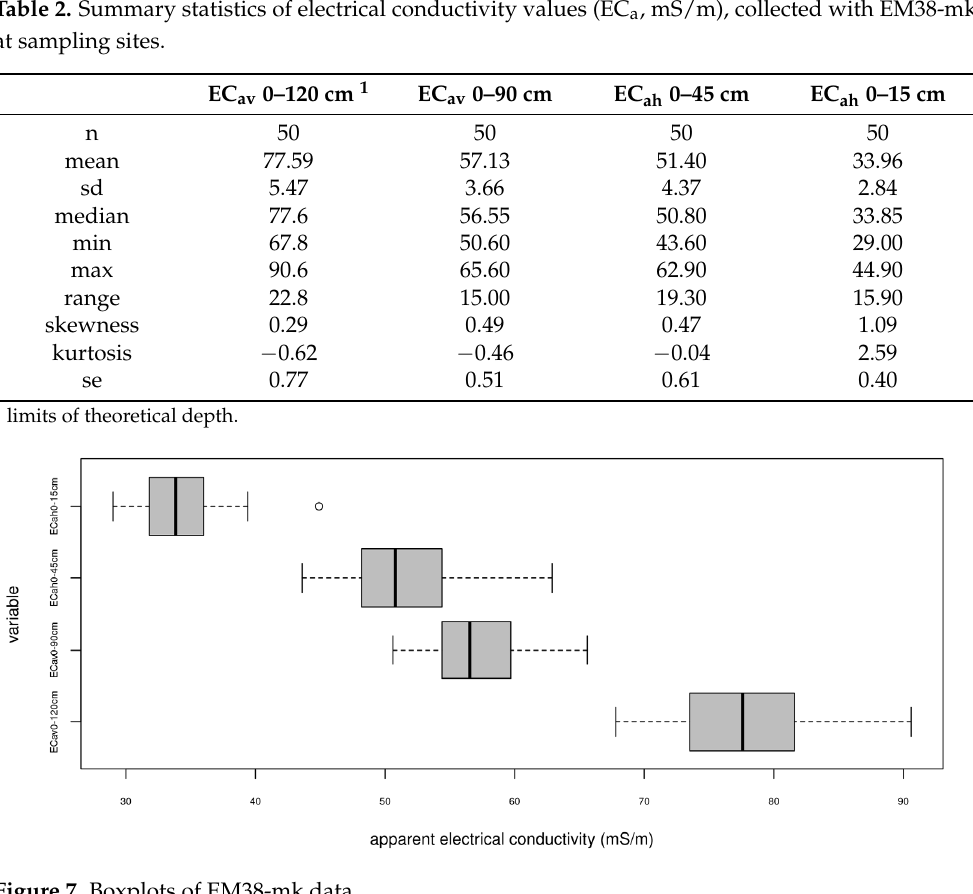
Figure 7. Boxplots of EM38-mk data.